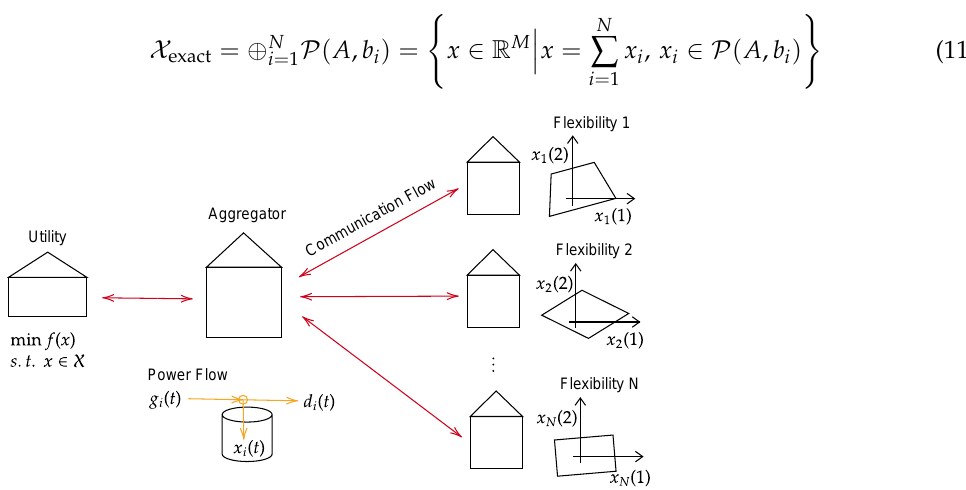
Figure 1. System model, directions of positive power flow, and sketches of two-dimensional house- hold